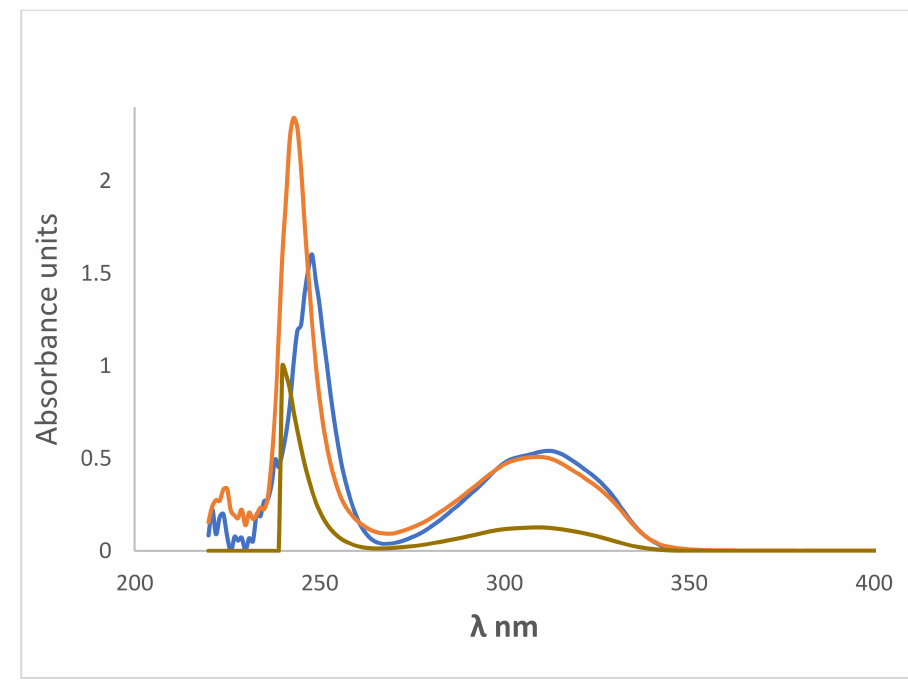
Figure 11. Absorption spectra of 9.2 × 10 − 6 M coumarin 4 in THF, CH 3 CN, and CHCl 3 .